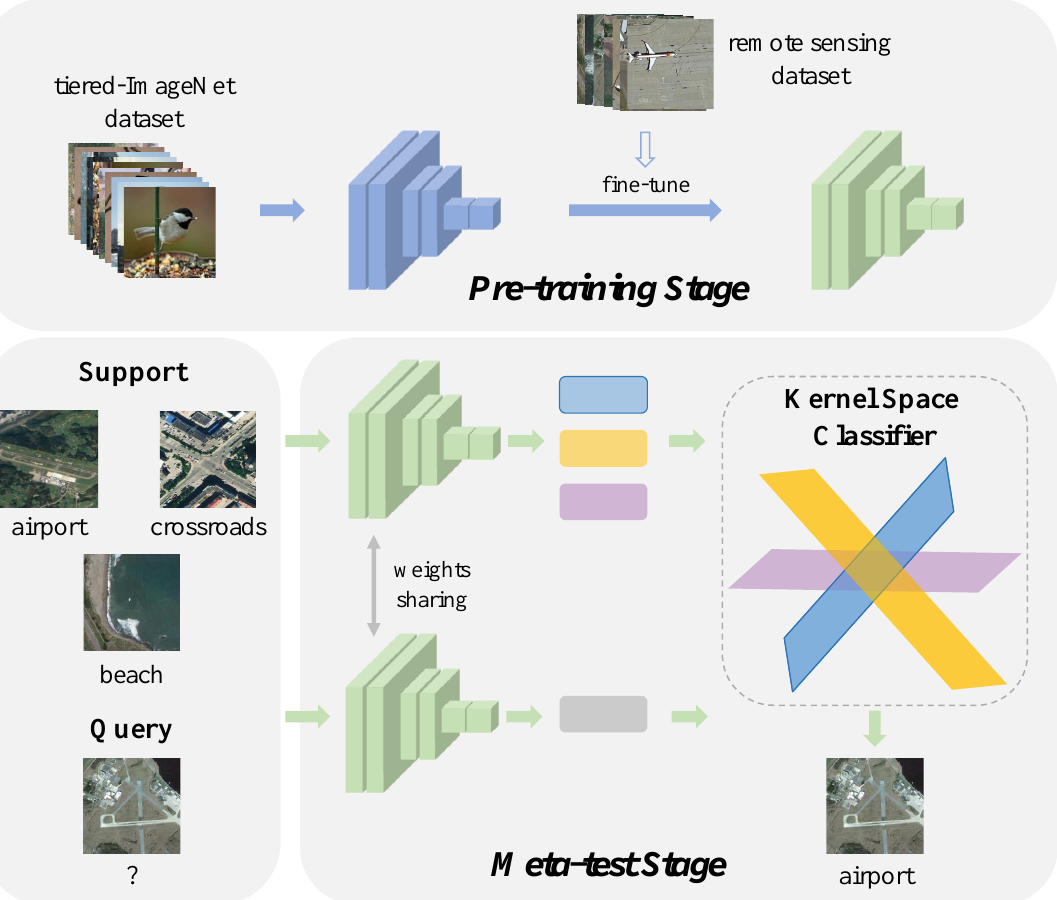
Figure 2. The framework of the proposed DL method consists of two stages: (1) the pre-training stage uses the tiered-ImageNet dataset to train a feature extractor, and then employs a remote sensing dataset to fine-tune the extractor. (2) The meta-test stage inputs the support set and the query set samples into the trained feature extractor to obtain the embedding features. We use the support features to train the kernel space classifier and predict the category of the query